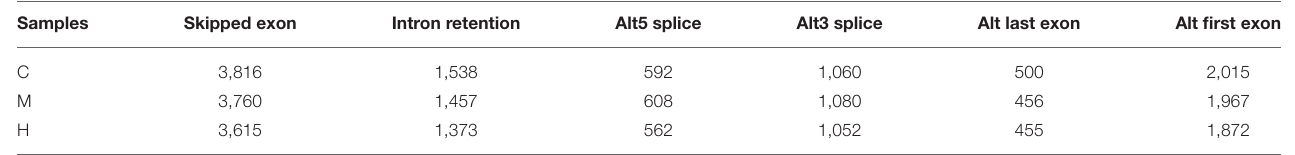
TABLE 7 | The numbers of new predicted alternative splicing events. Samples